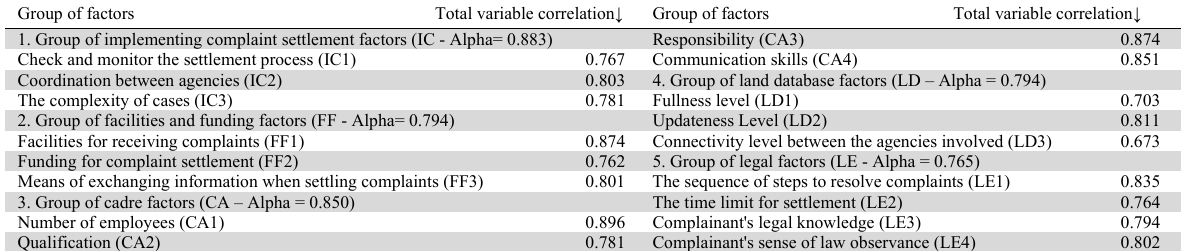
Results of analyzing the reliability of the scale. Group of